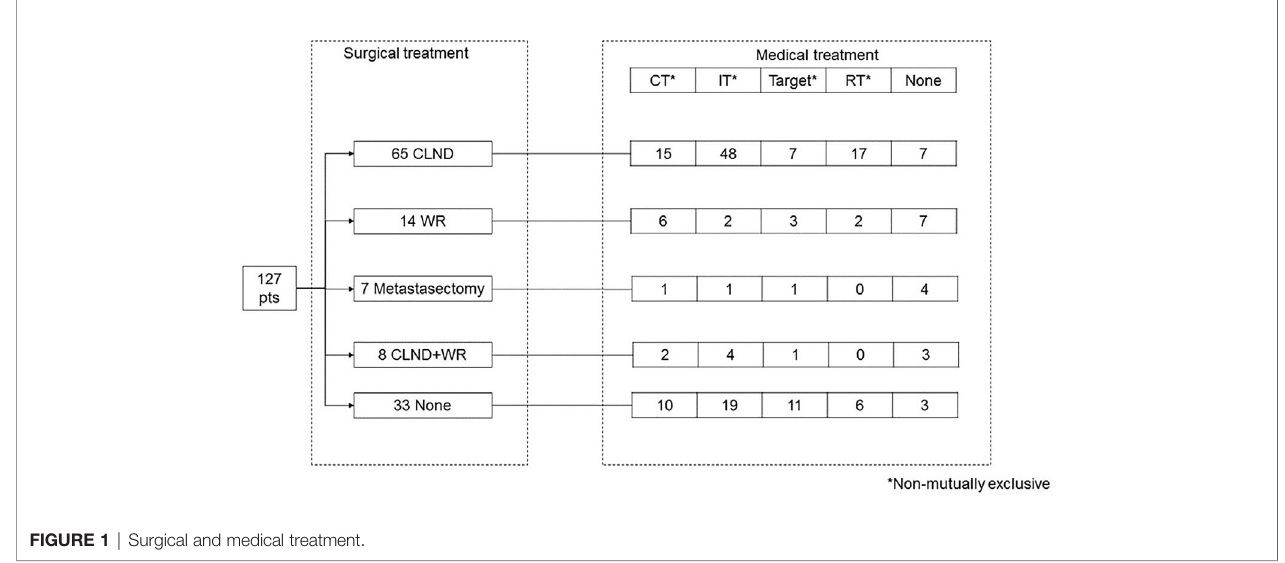
FIGURE 1 | Surgical and medical treatment.